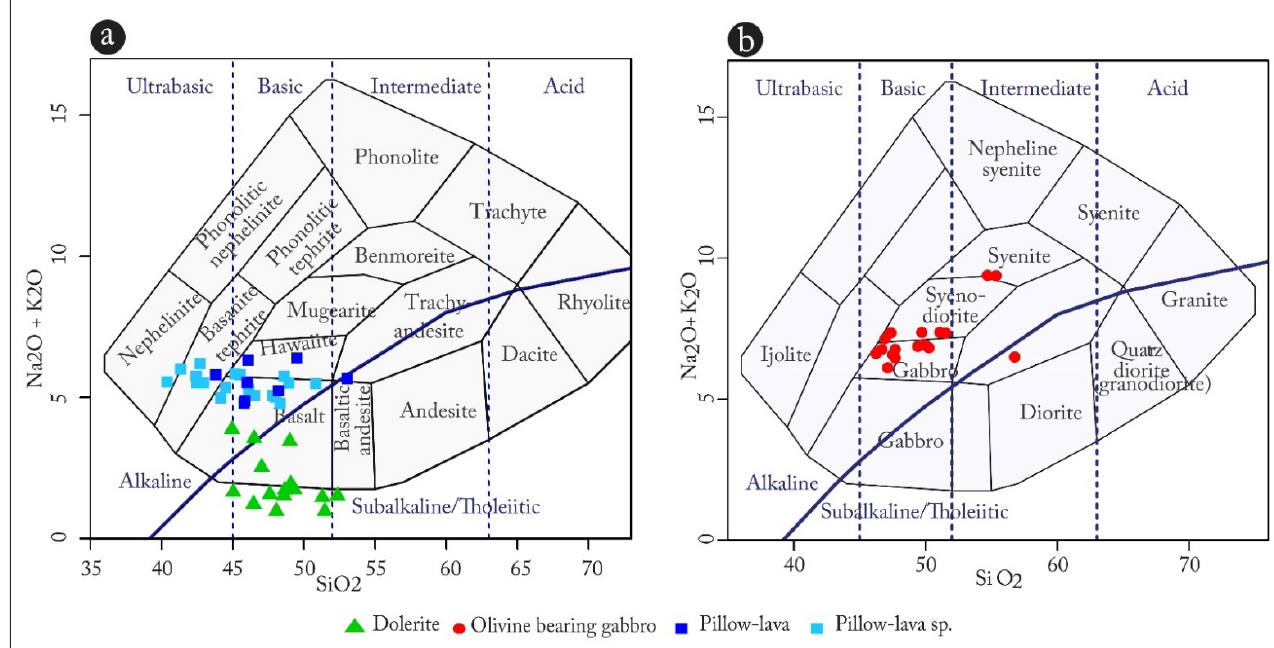
Figure 20. ( a ) SiO 2 -Na 2 O+K 2 O [58] “Volcanic rocks”, and ( b ) SiO 2 -Na 2 O+K 2 O [58] “Plutonic rocks” diagrams.